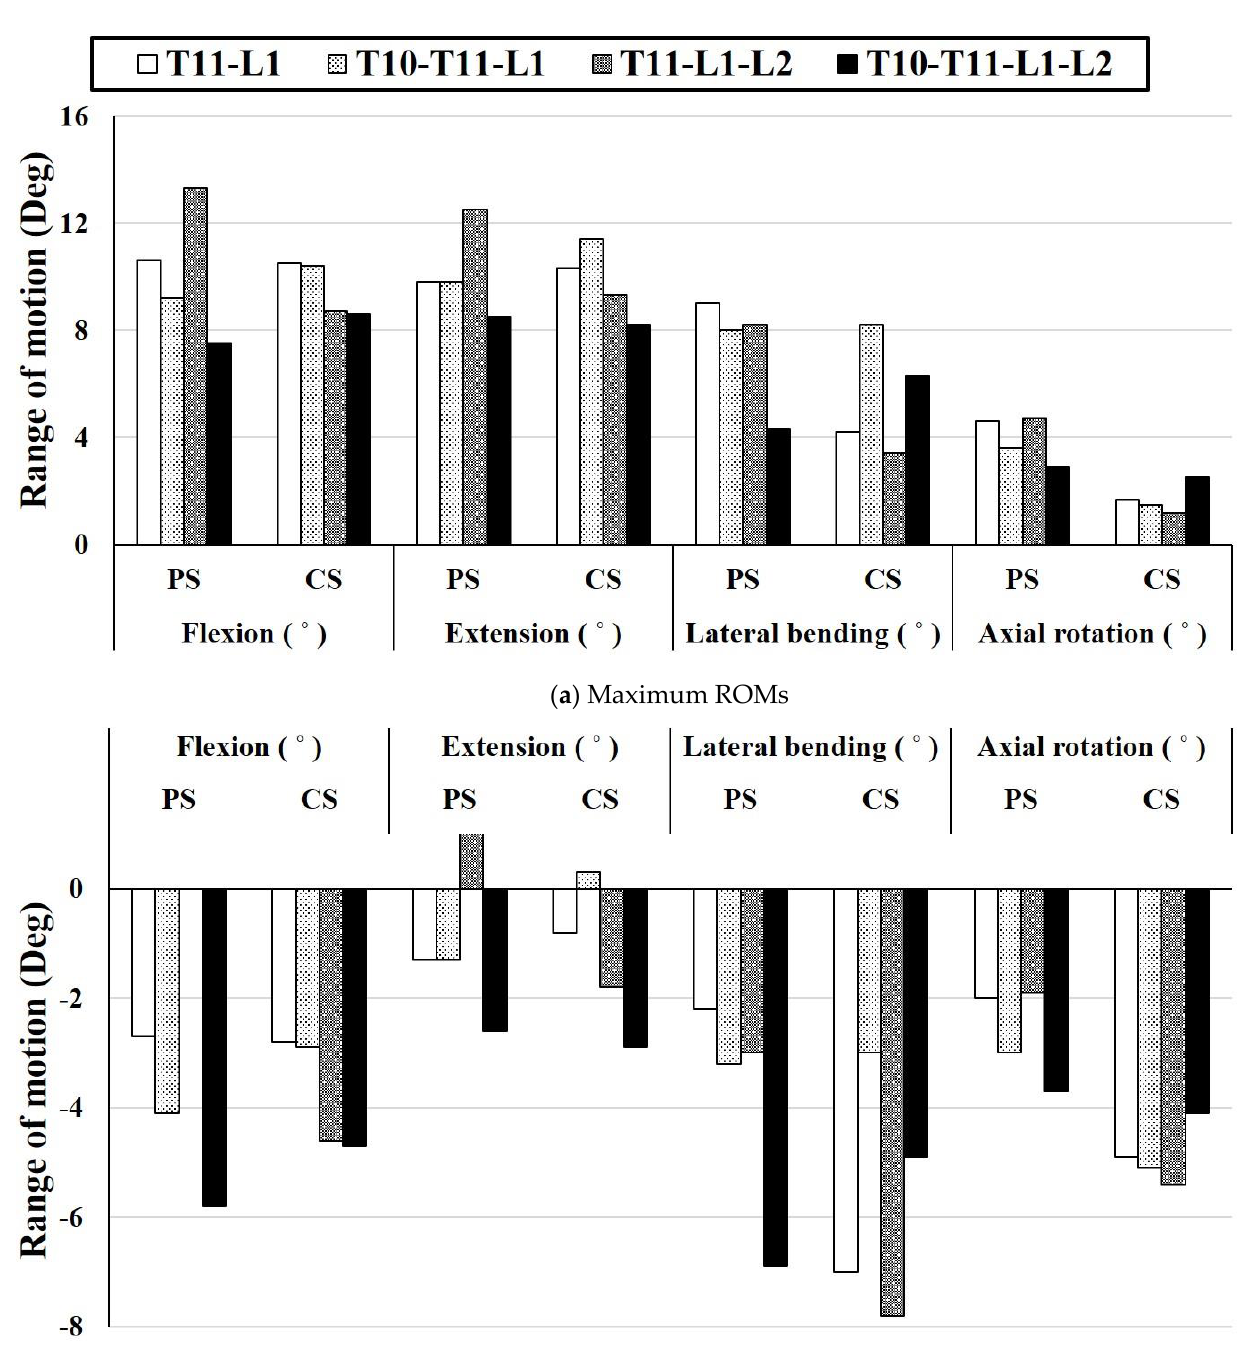
Figure 5. Comparison of the difference between the ROM result and intact model for all cases: ( a ) Maximum ROM for each motion based on the fixing method, ( b ) Difference value between ROM of the intact model and ROM based on each fixing method.